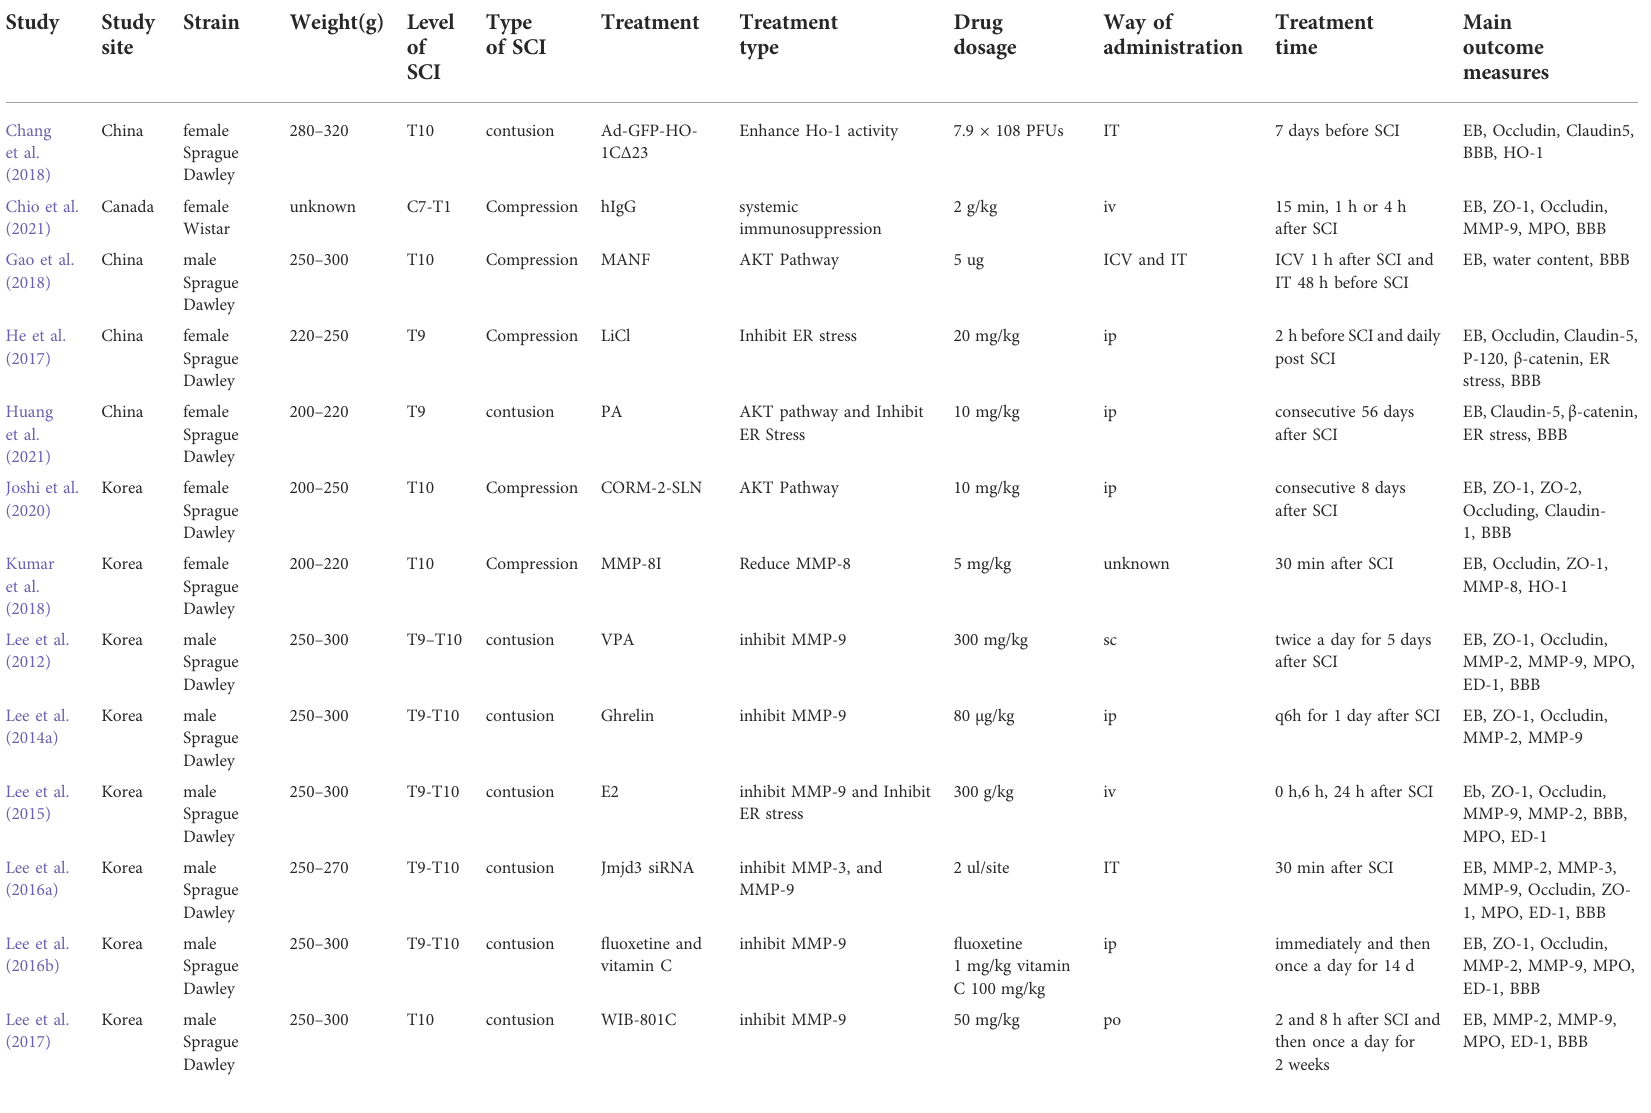
TABLE 1 Characteristics 506 of the included